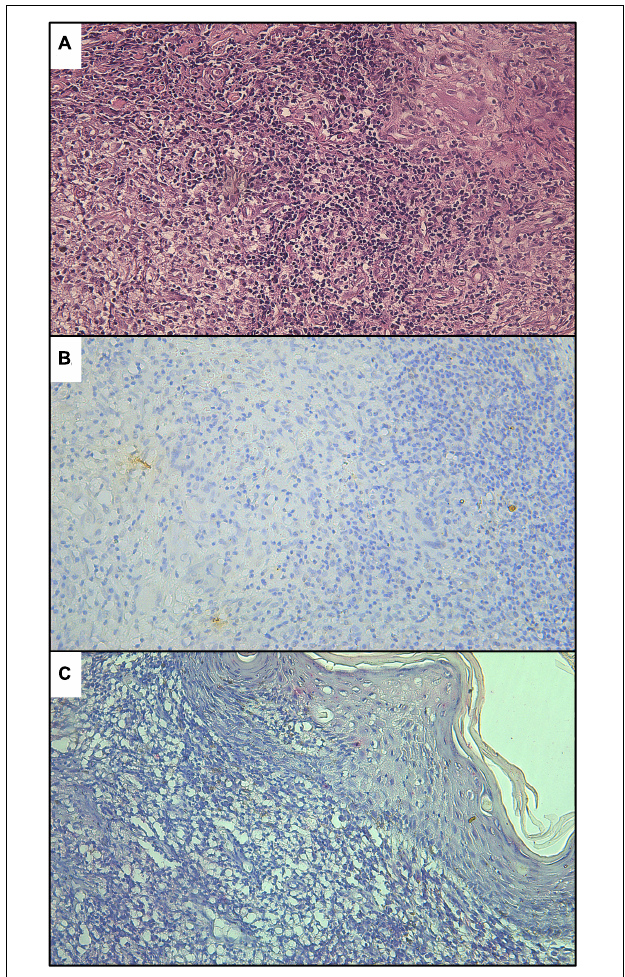
FIGURE 7 | Histological sections of skin lesions from non-cutaneous leishmaniasis patients, stained by hematoxylin–eosin (A) , IHC-HRP (B) , and IHC-AP (C)